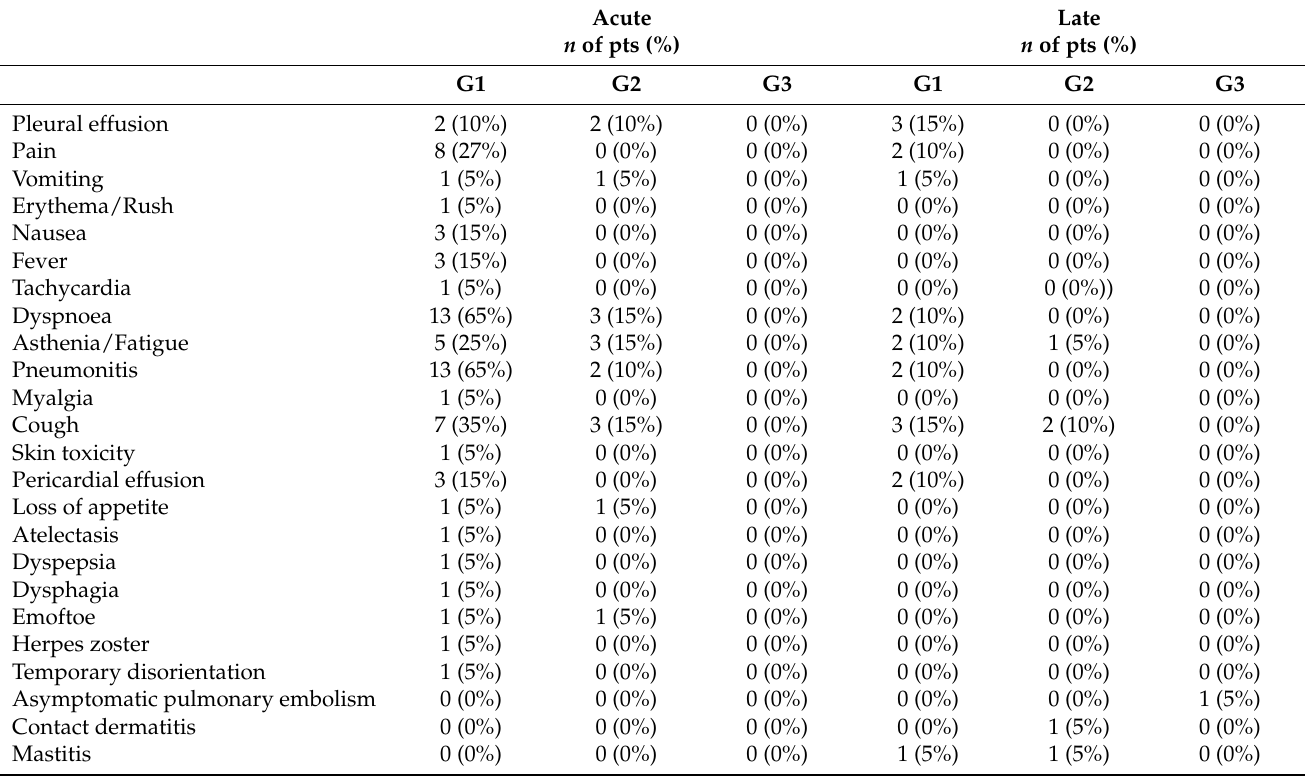
Table 2. Number of patients with reported AEs among patients with at least 1 cycle of treatment.